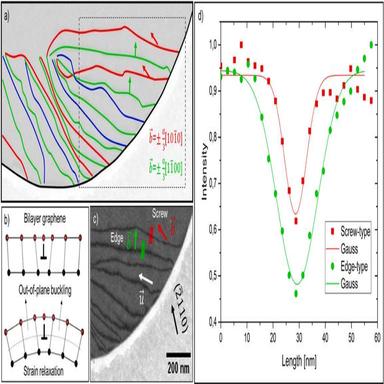
a) RGB color representation of the dislocations and their BVs studied in 2. c) Magnified region of a) with highlighted edge dislocation (green) and a close to screw dislocation (red). c) Intensity profile across the two dislocations marked in b) showing the wider contrast of the edge which can be attributed to strain redistribution as result of membrane buckling (b).